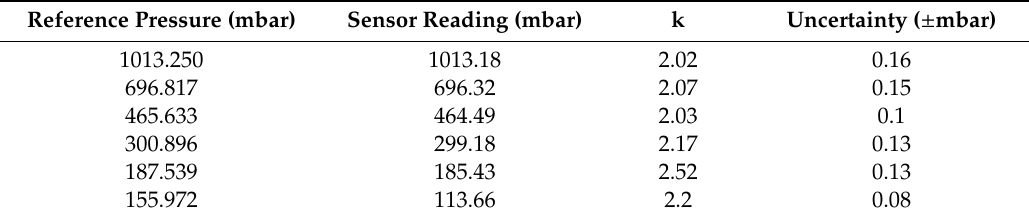
Table 5. Di ff erential pressure sensor calibration Table 5. Differential pressure sensor calibration sheet.